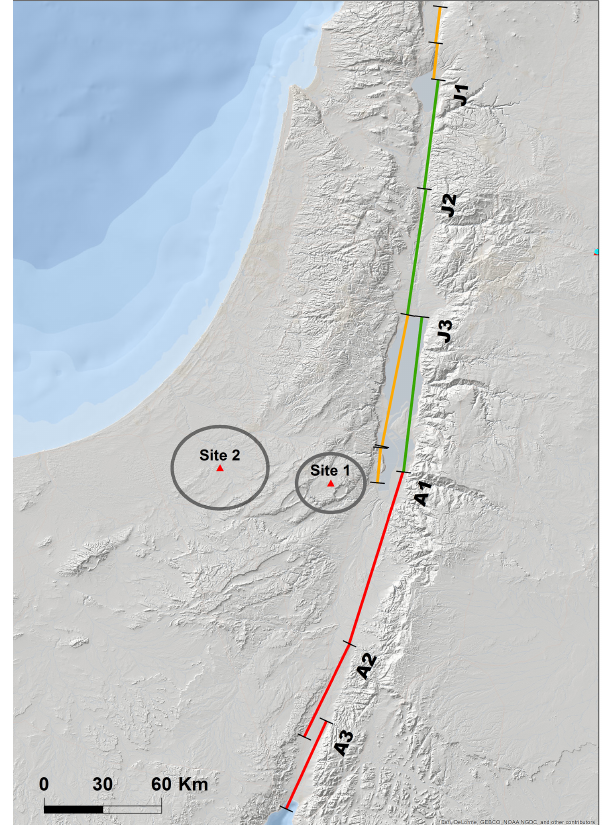
Figure 6. The segmented model of the DST in which the Arava and Jericho faults are each represented by three segments. The Arava Fault is represented by the red lines numbered A1 through A3. The Jericho Fault is represented by the green lines numbered J1 through J3. Orange lines represent segments which were not included in the analysis herein, to avoid double-counting of moment